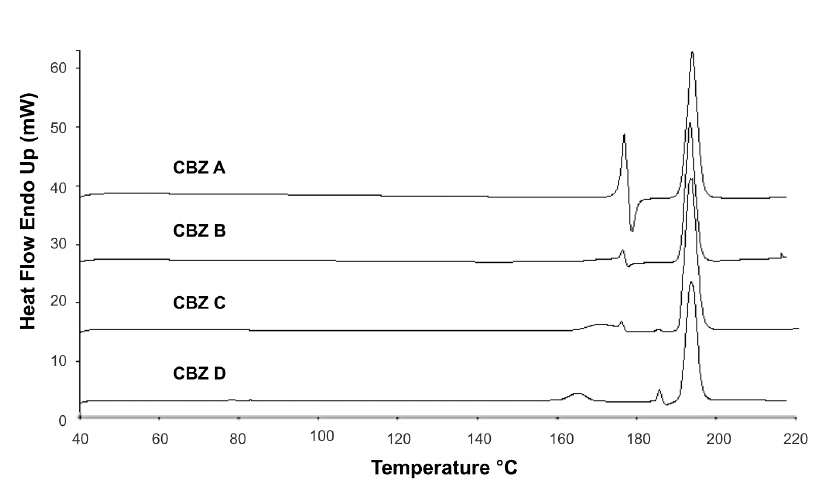
Figure 4. DSC profiles of untreated CBZ samples; 10 °C/min scanning